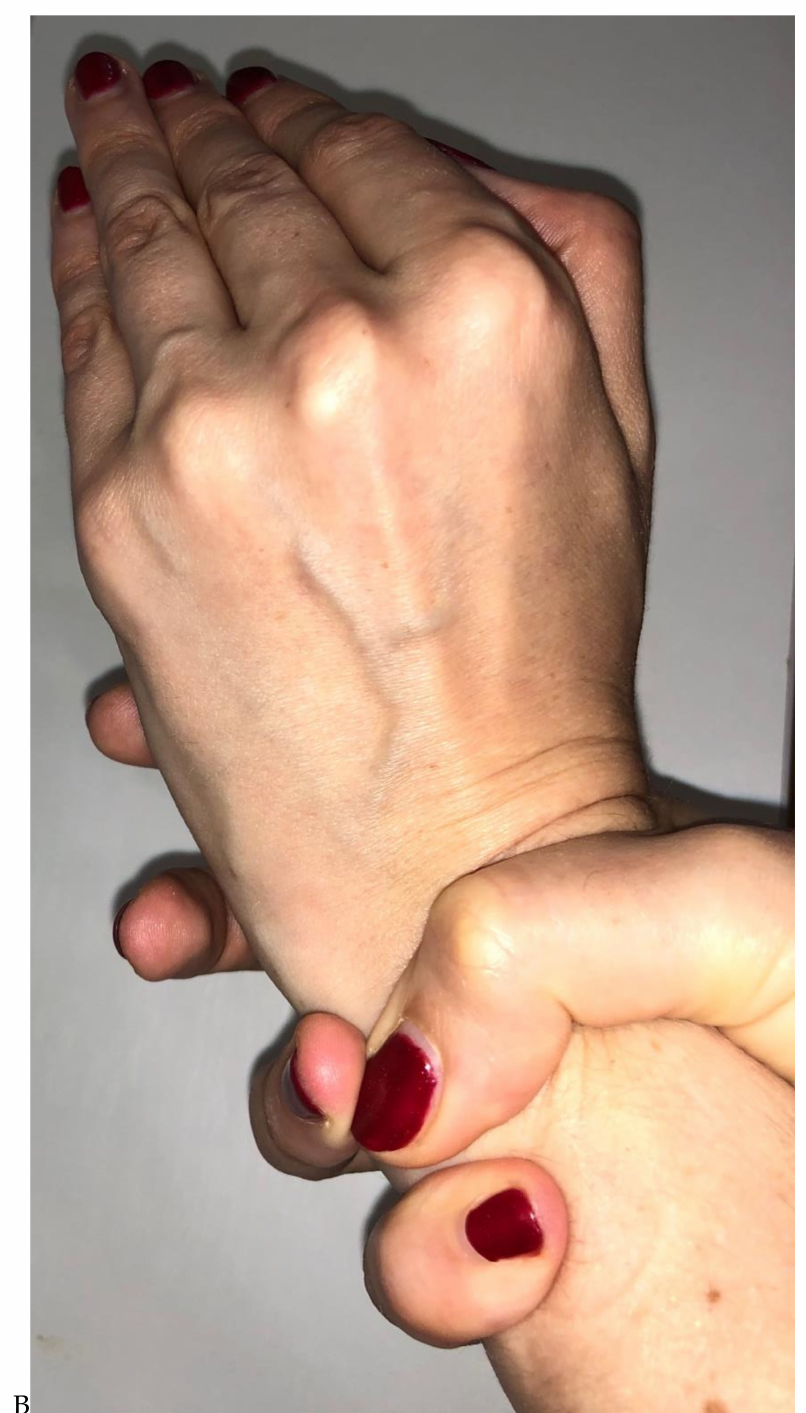
Figure 1. Some of the phenotypical traits of the patient: hyperextensible skin (above the lateral edge of the clavicle) ( A ) and arachnodactyly (test of grip of the wrist with one and five fingers) ( B